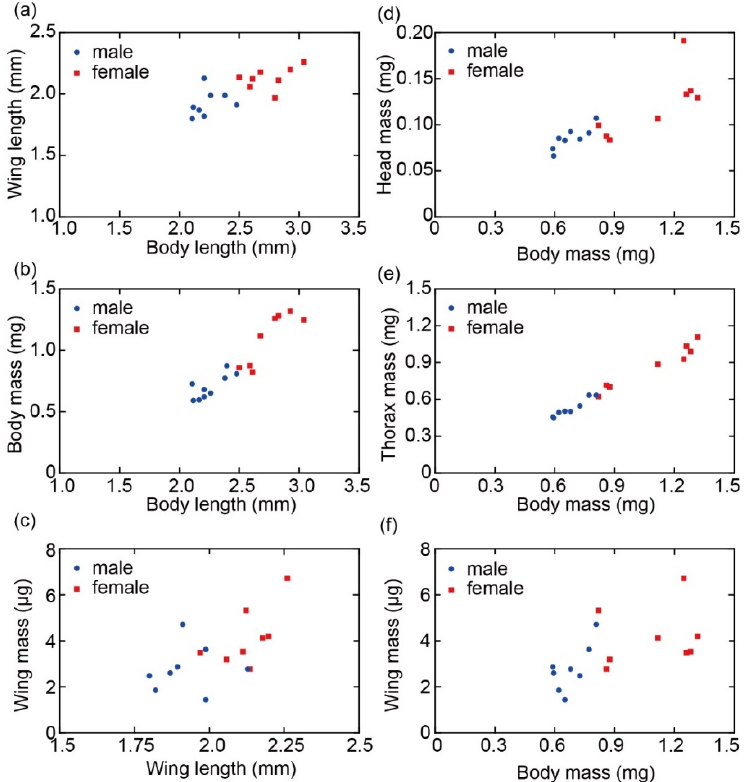
Figure 14. Relationship between ( a ) body length and wing length, ( b ) body length and body mass, ( c ) wing length and wing mass, ( d ) body mass and head mass, ( e ) body mass and thorax/abdomen mass, and ( f ) body mass and wing mass.